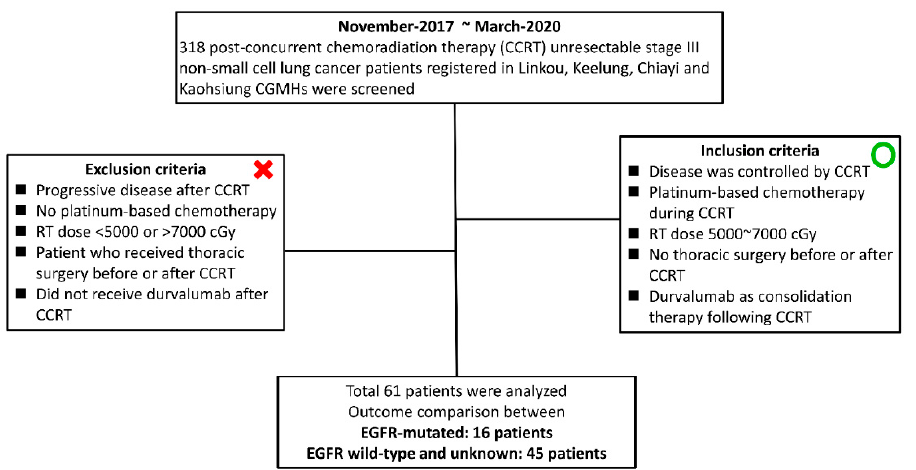
Figure 1. Flowchart of patient recruitment in this